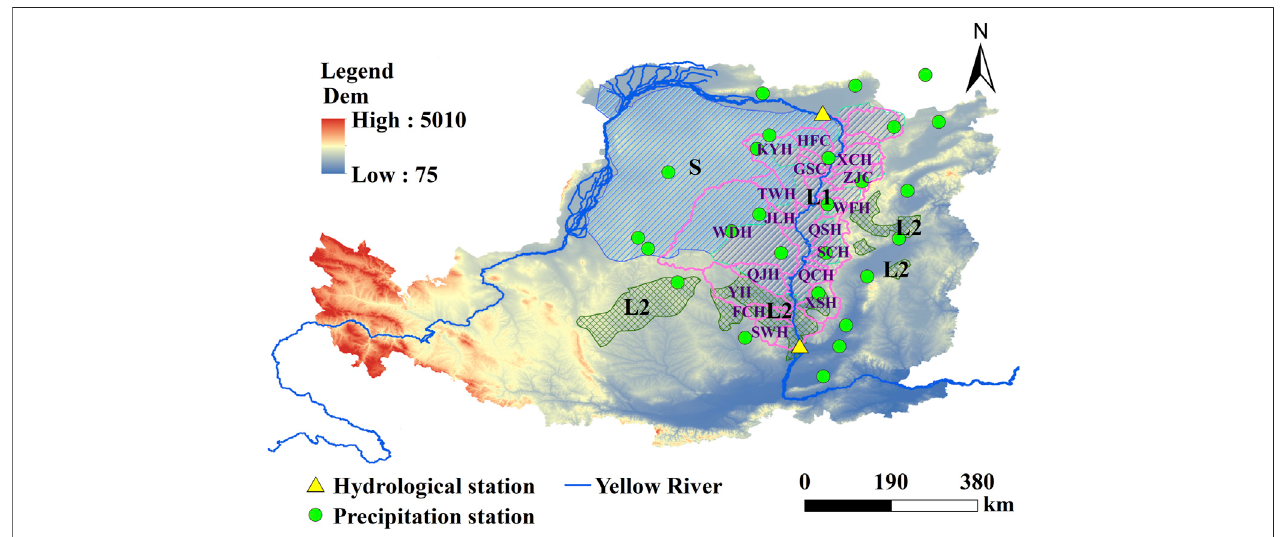
FIGURE1| Locationofstudyarea.L1,L2andSrepresentthe fi rstloesshillsubregion,thesecondloesshillsubregionandthesandstormregion,respectively.The pink shapes depict the boundaries of the 21 tributaries of the Hekou-Longmen region, and the tributaries labeled with names are the selected tributaries. The tributary names used here are abbreviated, where HPC represents huangpuchuan, KYH represents kuyehe, TWH represents tuweuhe, ZJC represents zhujiachuan, XCH represents xianchuanhe, GSC represents gushanchuan, WFH represents weifenhe, JLH represents jialuhe, QSH represents qiushuihe, SCH represents shanchuanhe, QCH represents quchanhe, WDH represents wudinghe, QJH represents qingjianhe, XSH represents xinshuihe, SWH represents shiwanghe, YH represents yanhe, FCH represents fenchuanhe.